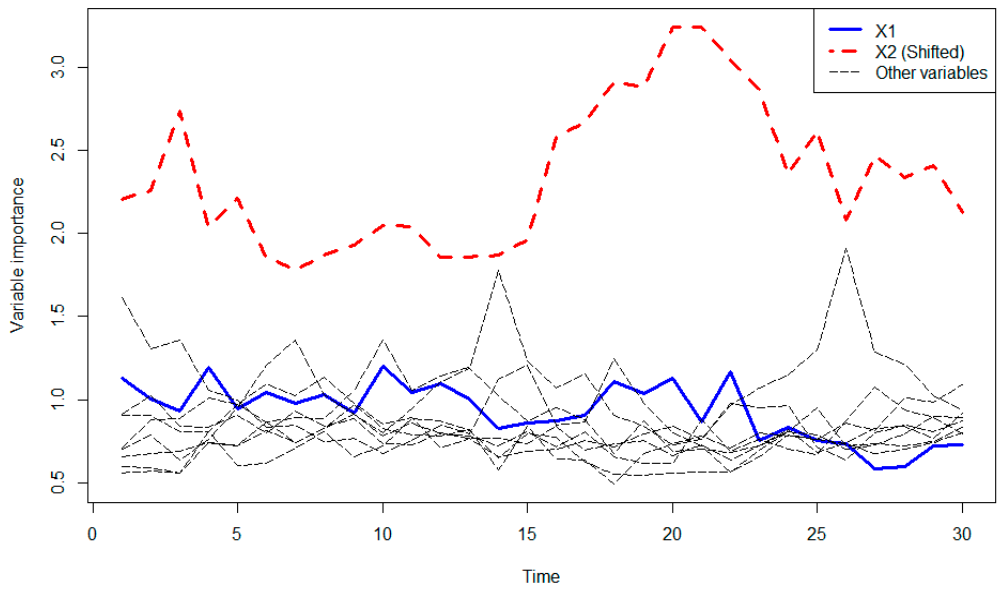
Figure 5. Variable importance; number of trees = 500, window size = 10.